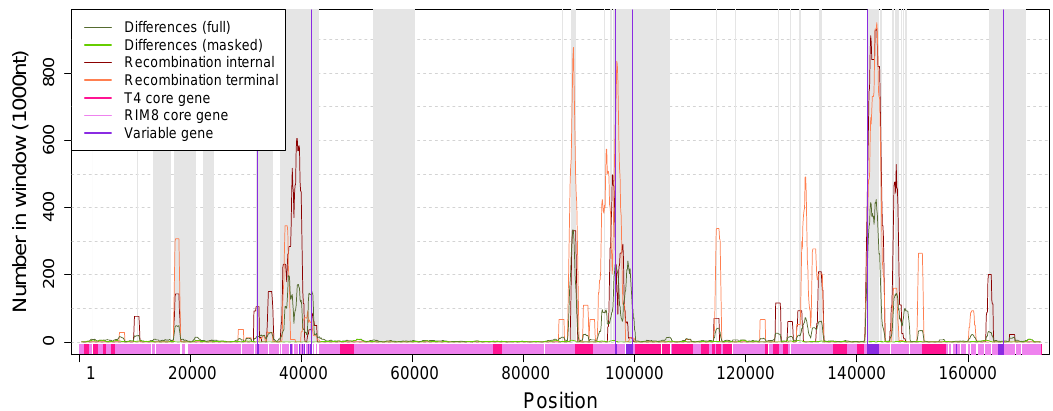
Figure 4. Numbers of di ff erences and positions in recombination events along the whole-genome alignment. Regions shaded in gray are absent in the masked alignment. Numbers of di ff erences and recombination positions are shown for windows of size 1000 with an o ff set of 100. Variable genes cluster in three regions (marked by vertical violet lines). Region 1: 32,085—41,835, Region 2: 96,595–99,589, Region 3: 141,976–166,384. The whole alignment contains 11,837 (6.8%) positions that are involved